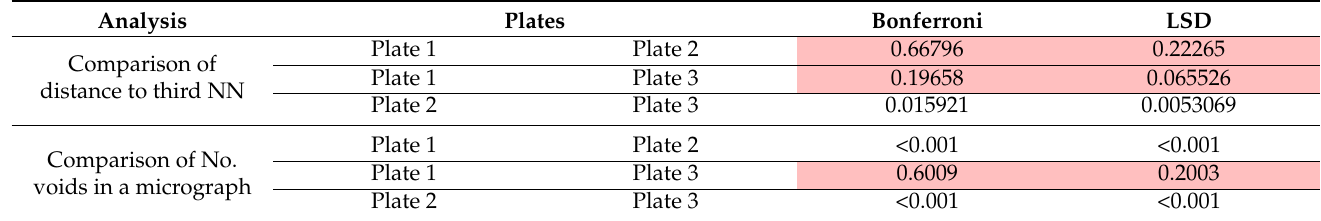
Table 20. Void data for Plate